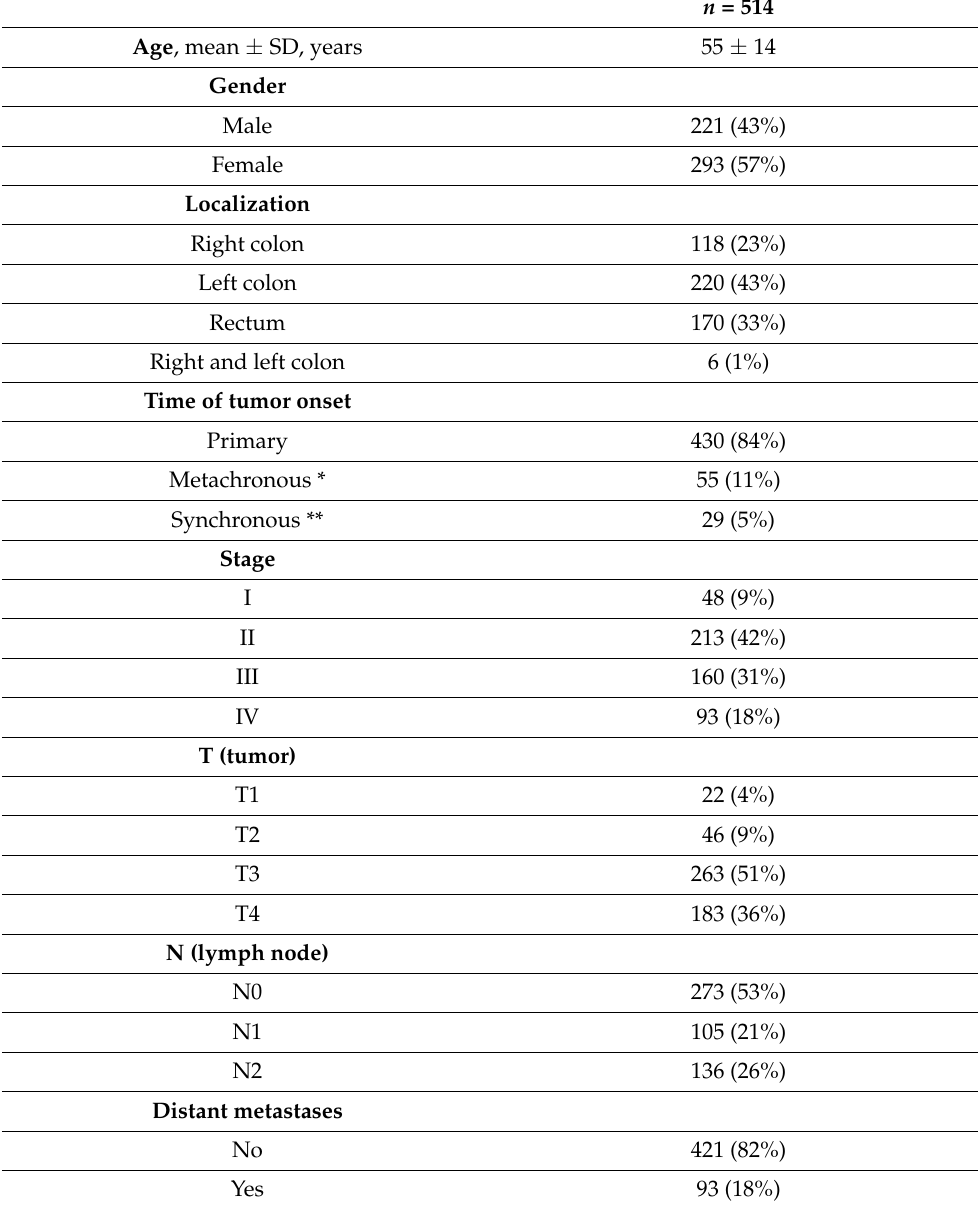
Table 4. Data patients of